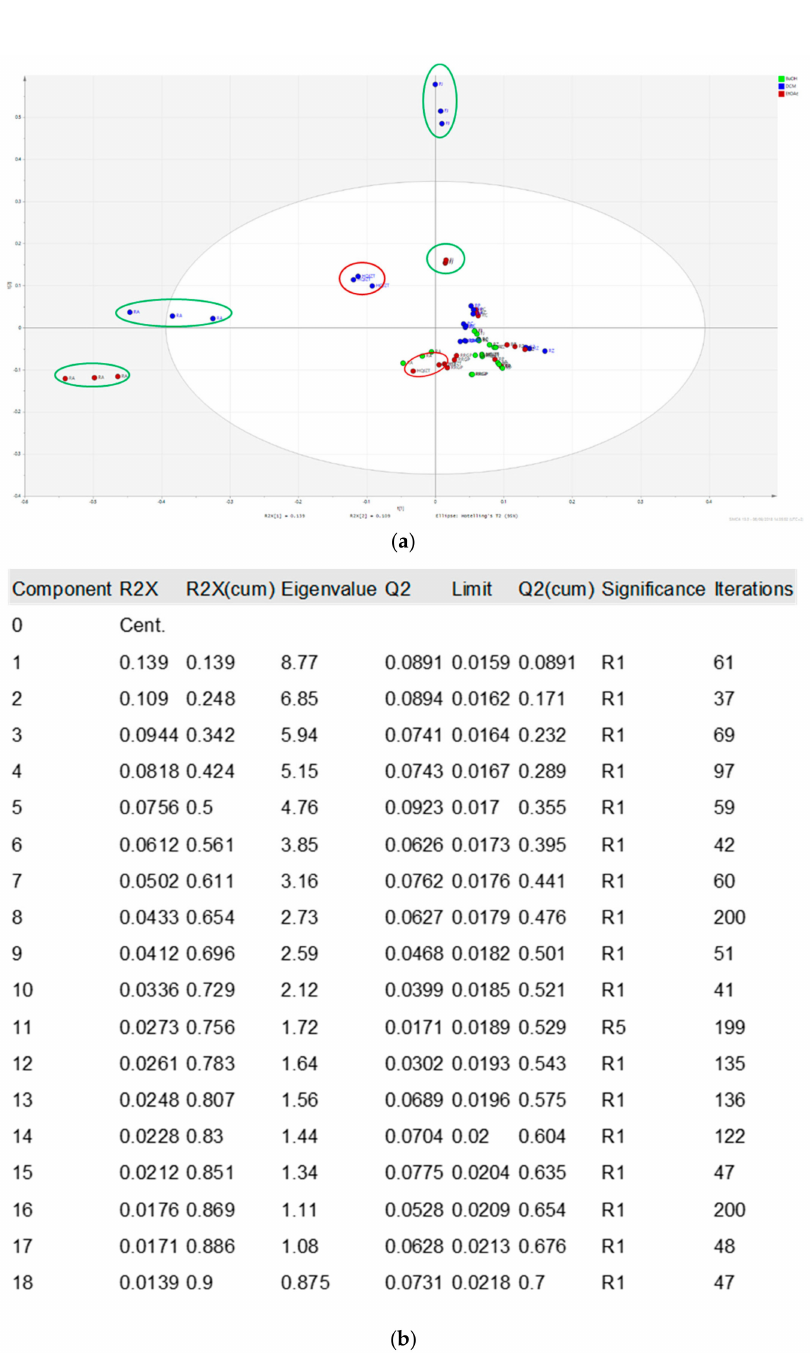
Figure 4. PCA t[1] / t[2] Score scatter plot of the UPLC-QTOF-MS data of all pharmacologically tested samples from Huangqi Jianzhong Tang (green: n-BuOH fractions; blue: DCM fractions; red: EtOAC fractions) ( a ) PCA plot; ( b ) model